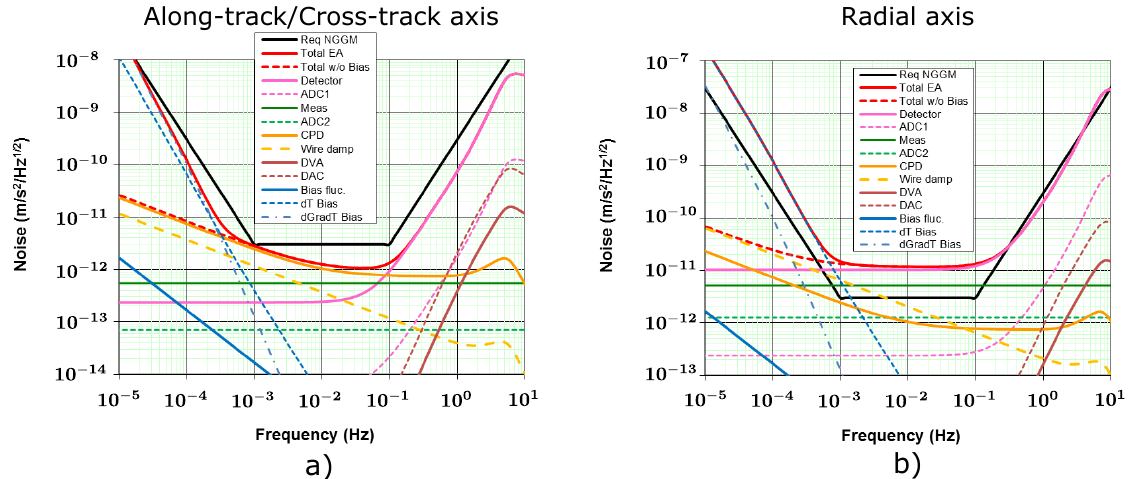
Figure 29. ( a ) HybridSTAR accelerometer performance on the along-track and cross-track axis. ( b ) HybridSTAR accelerometer performance on the radial